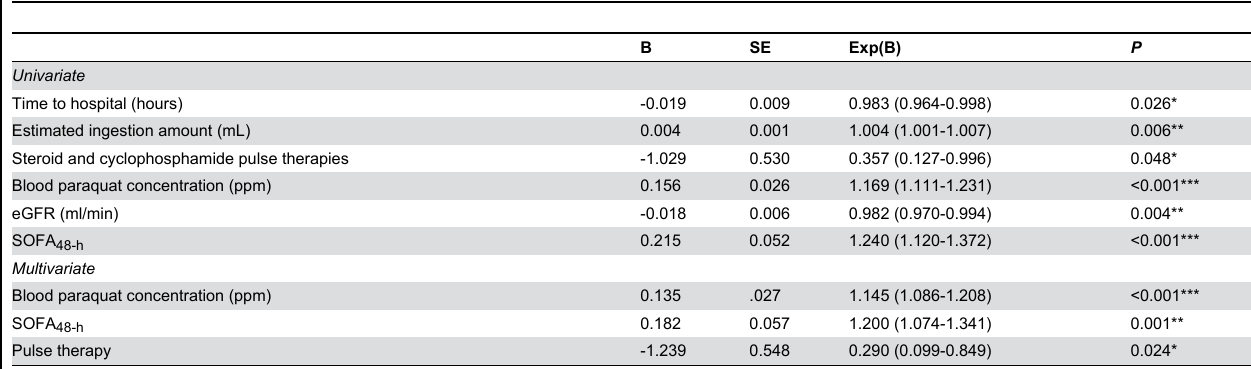
Table 5. Analysis of mortality using univariate and multivariate Cox regression models (n = 187).